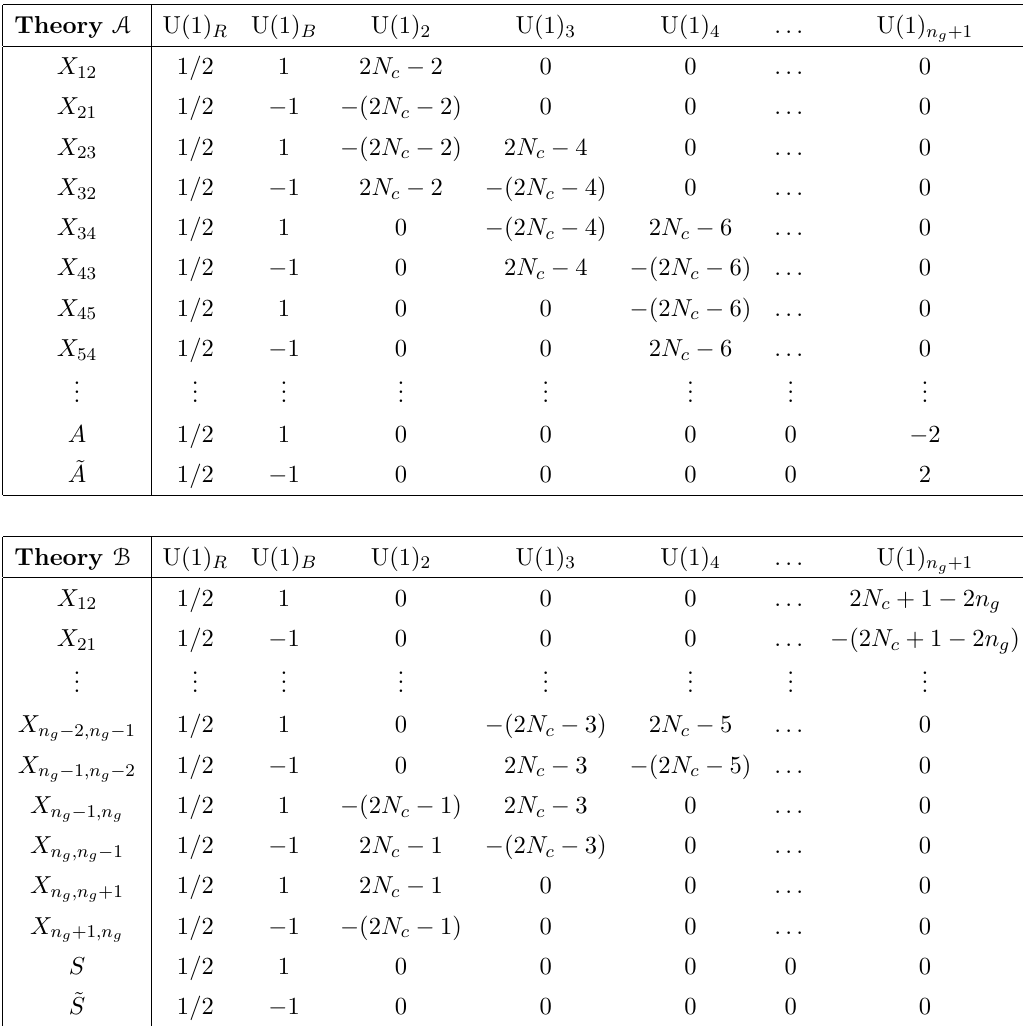
Table 4 . Baryonic symmetry map across the duality between a quiver of type A (4.3) and a quiver of type B